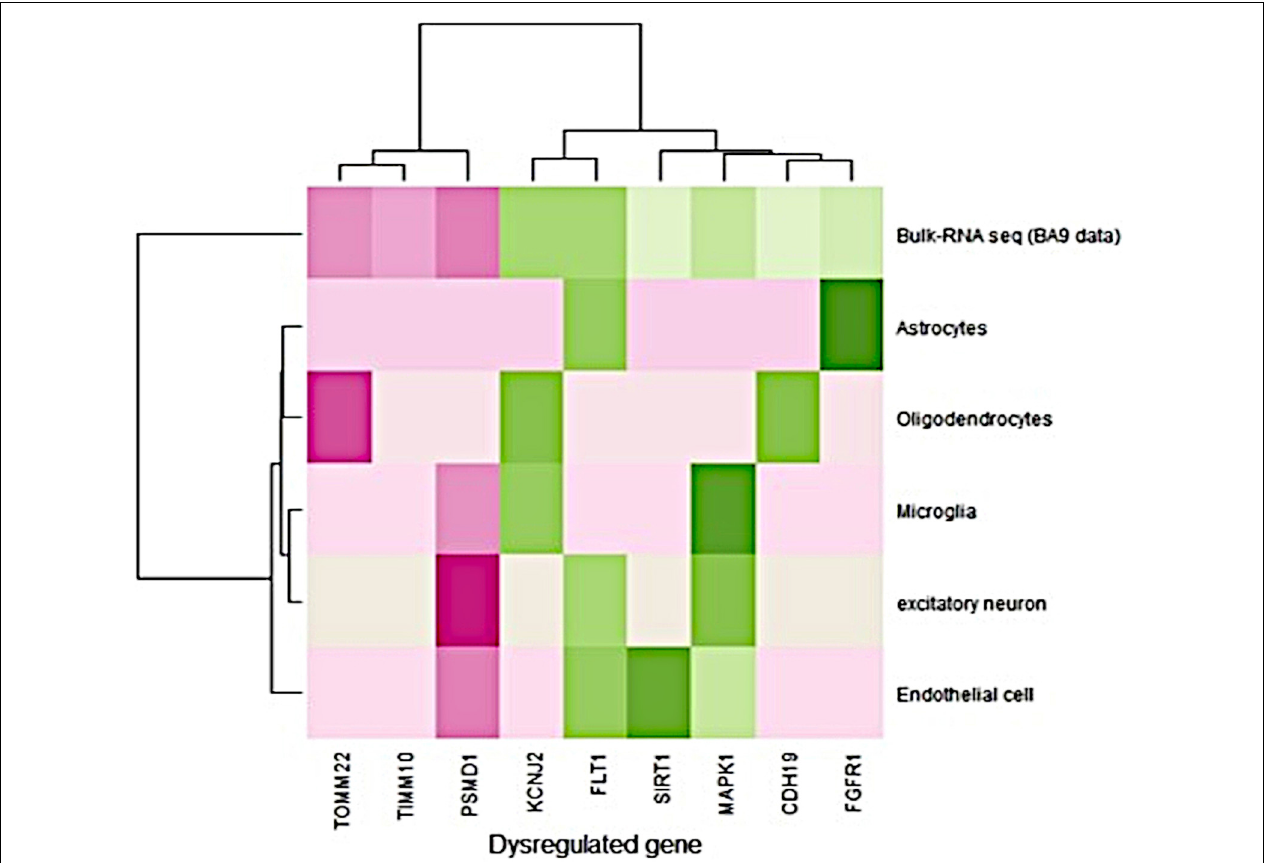
FIGURE 1 | Comparison of gene expression profiles between bulk and single nuclei RNA-seq